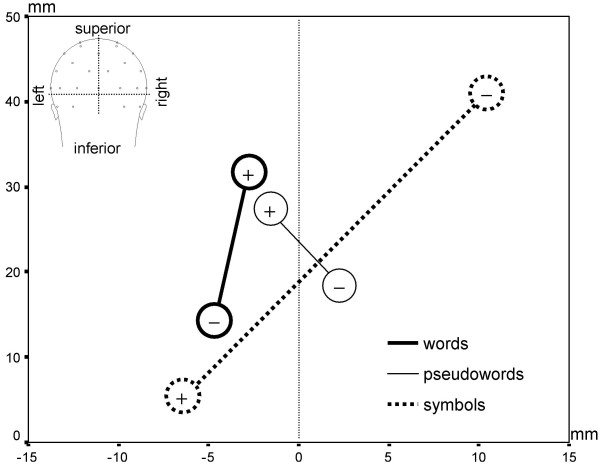
Positive and negative centroids of the N170 word, pseudoword, and symbol topographies. Symbol centroids show a different pattern from word and pseudoword centroids, with a reversed polarity in the inferior-superior direction. In addition, the negative centroid is left-lateralized for words, but right-lateralized for symbols. The centroids are also more left-lateralized for words than for pseudowords. Note that the centroids represent the ERP topography on the scalp surface and are by no means estimations of the underlying sources.